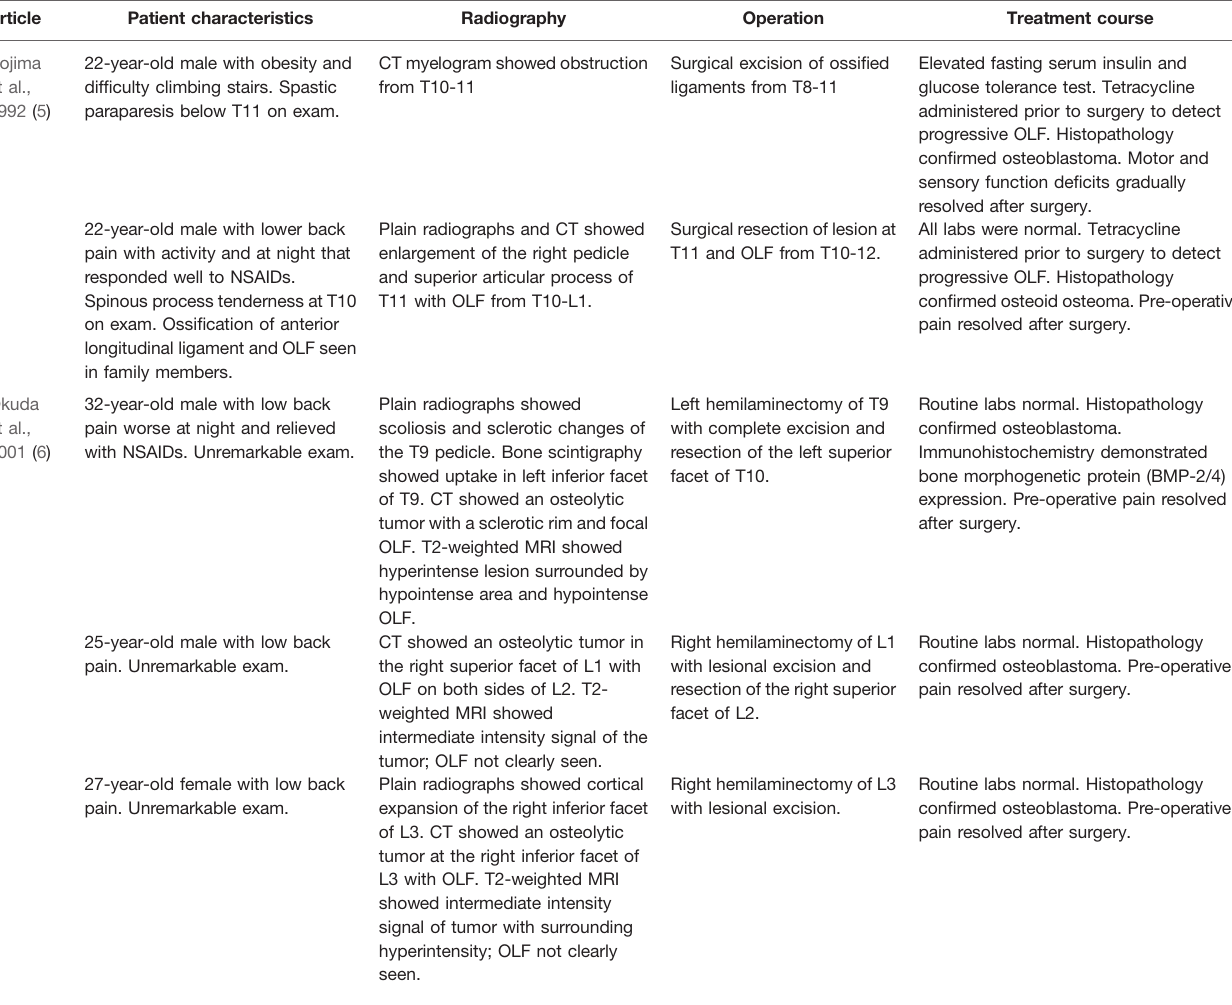
TABLE 1 | Literature review of osteoblastoma & osteoid osteoma cases with associated ossi fi cation of the ligamentum fl